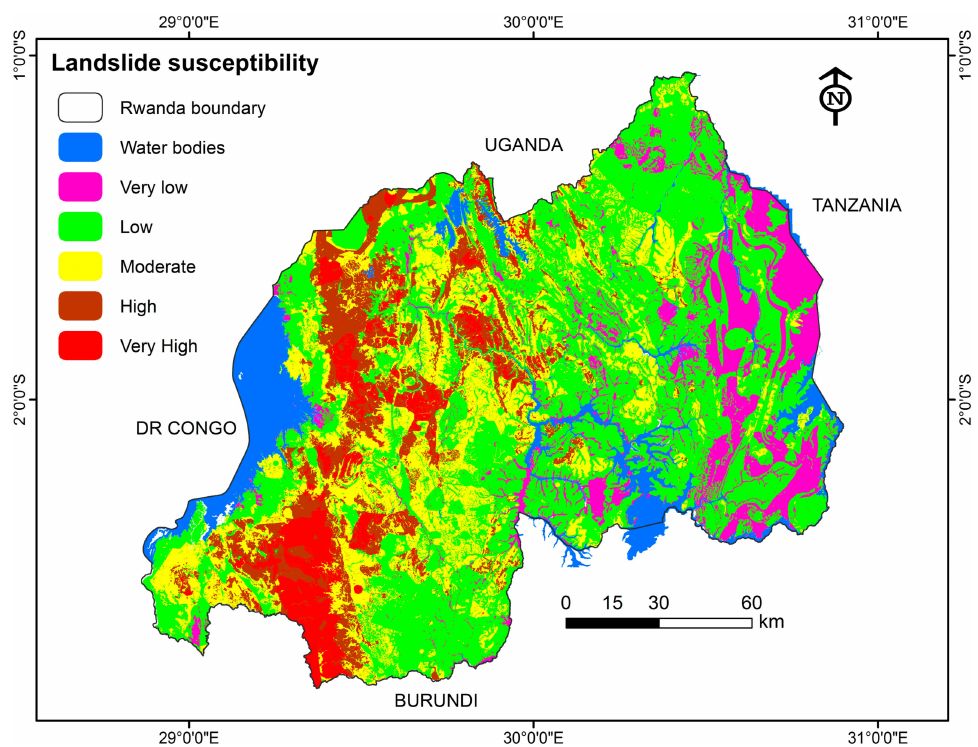
Figure 9. Landslides susceptibility map of Rwanda produced by Spatial Multi-Criteria